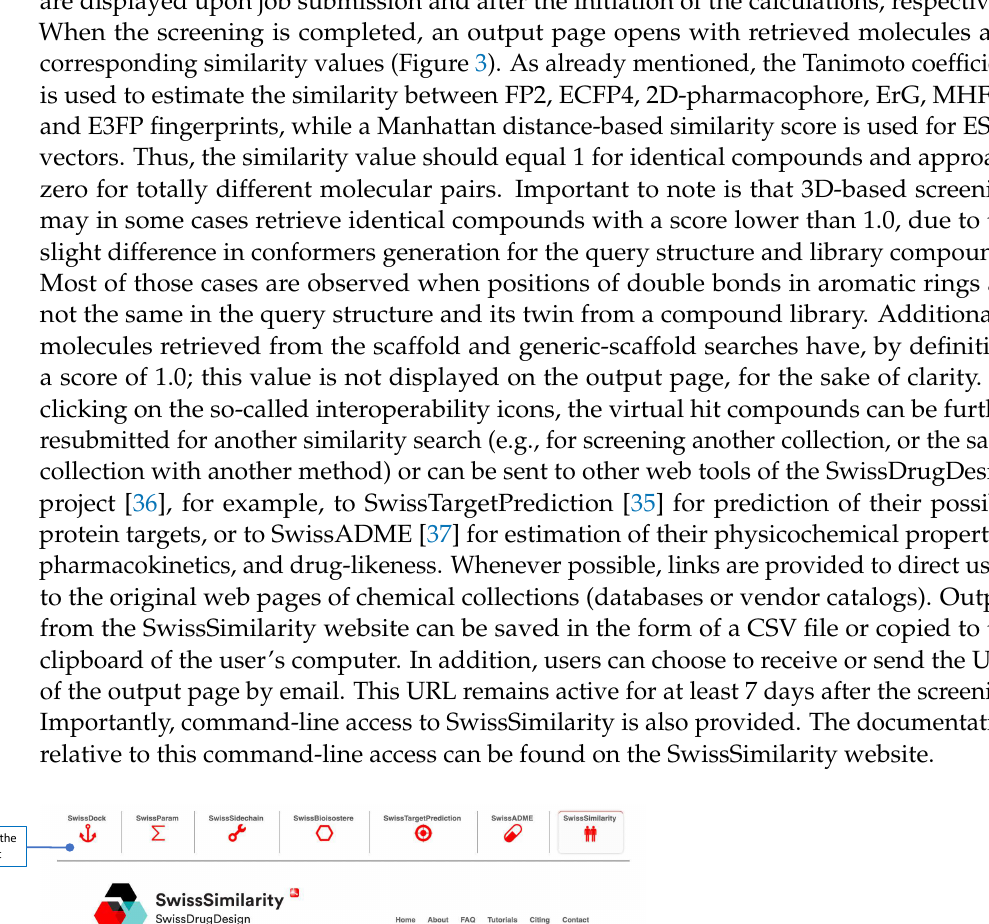
Figure 3. Example of an output page to analyze the most similar molecules to the query by, e.g., accessing the database of origin, or submitting a given compound to other SwissDrugDesign tools through the interoperability icons. 4. Conclusions The updated version of the SwissSimilarity Web tool has been launched to incorporate novel approaches for molecular fingerprinting and provide access to updated chemical libraries. In addition, the SwissSimilarity interface has been greatly improved to achieve an enriched user experience. Virtual screening with SwissSimilarity is very easy: users only need to submit a reference compound and choose a preferred library/method combination. While the similarity principle is one of the main concepts in medicinal chemistry and chemoinformatics, SwissSimilarity is primarily intended for drug